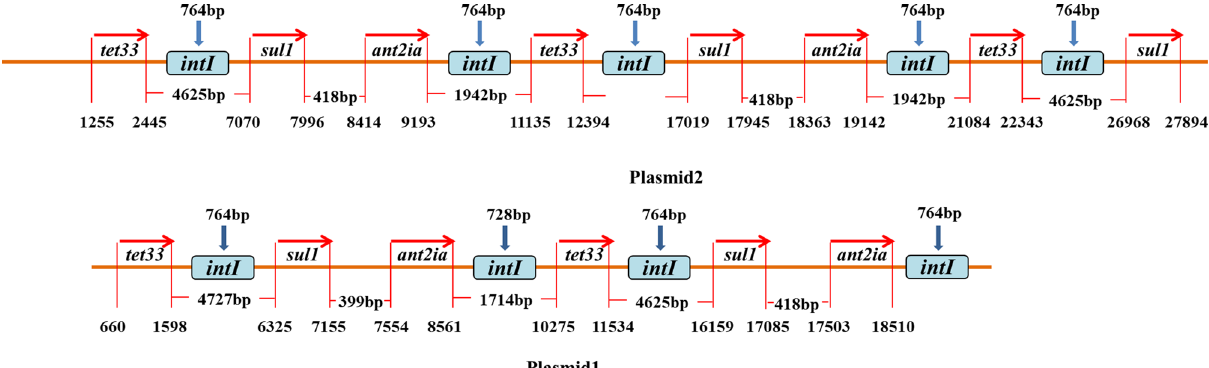
Figure 6. The sites of gene sul1 , tet33 and ant2ia on plasmid 1 and plasmid